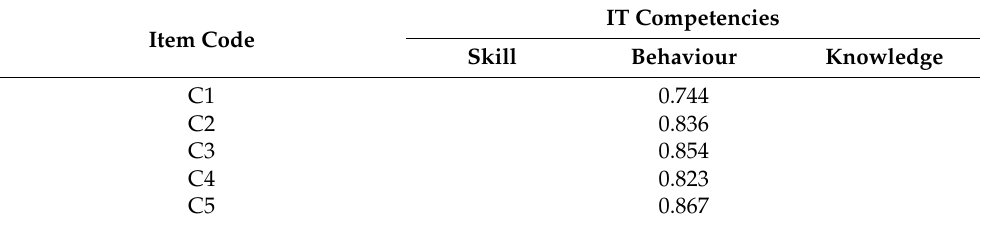
Table 5. Factor analysis of